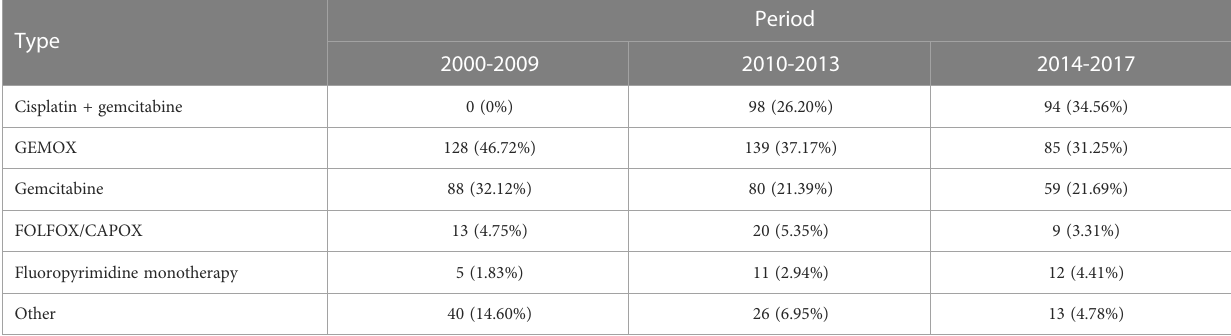
TABLE 2 Types of fi rst-line chemotherapy administered.